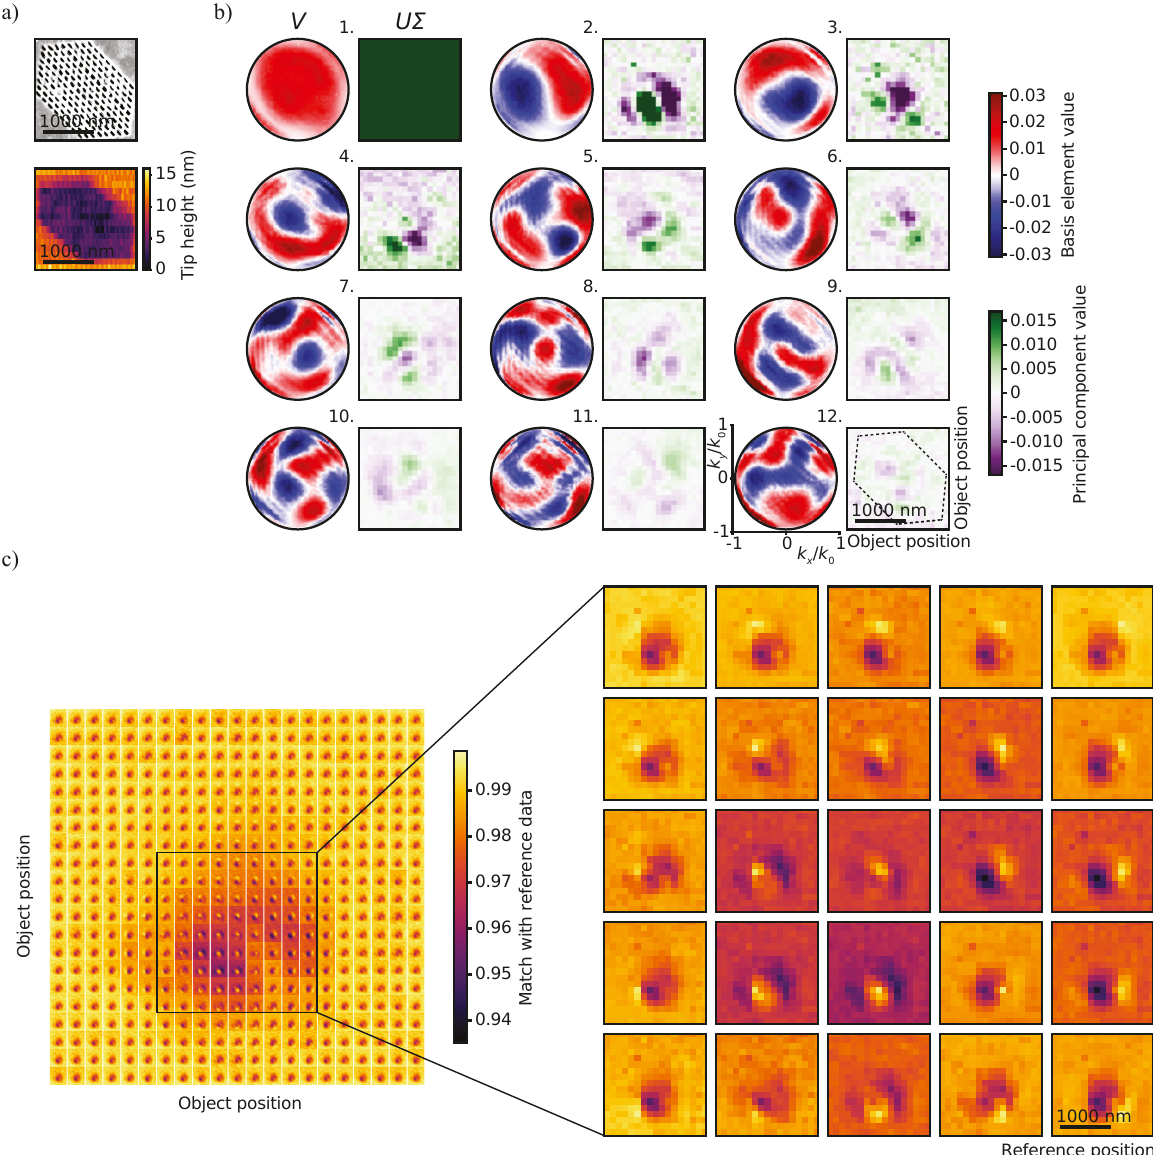
Figure 5: Measured dependence of the radiation pattern on the object position for a two-dimensional aperture array. (a) SEM image (top) and shear-force topography scan (bottom) of the transducer. (b) Singular value decomposition of a set of reference data for 21 × 21 probe points covering an area of 2 × 2 μ m in 100 nm steps. Shown are the first twelve principal component directions V (blue–red), forming a radiation pattern basis, and matching principal components U Σ (purple–green), representing the importance at each object position. (c) Match of signal data with reference data. Each of the images in the 21 × 21 grid shows the match of a newly acquired radiation pattern at this position with all positions of the reference data set. Some positions are highlighted to the